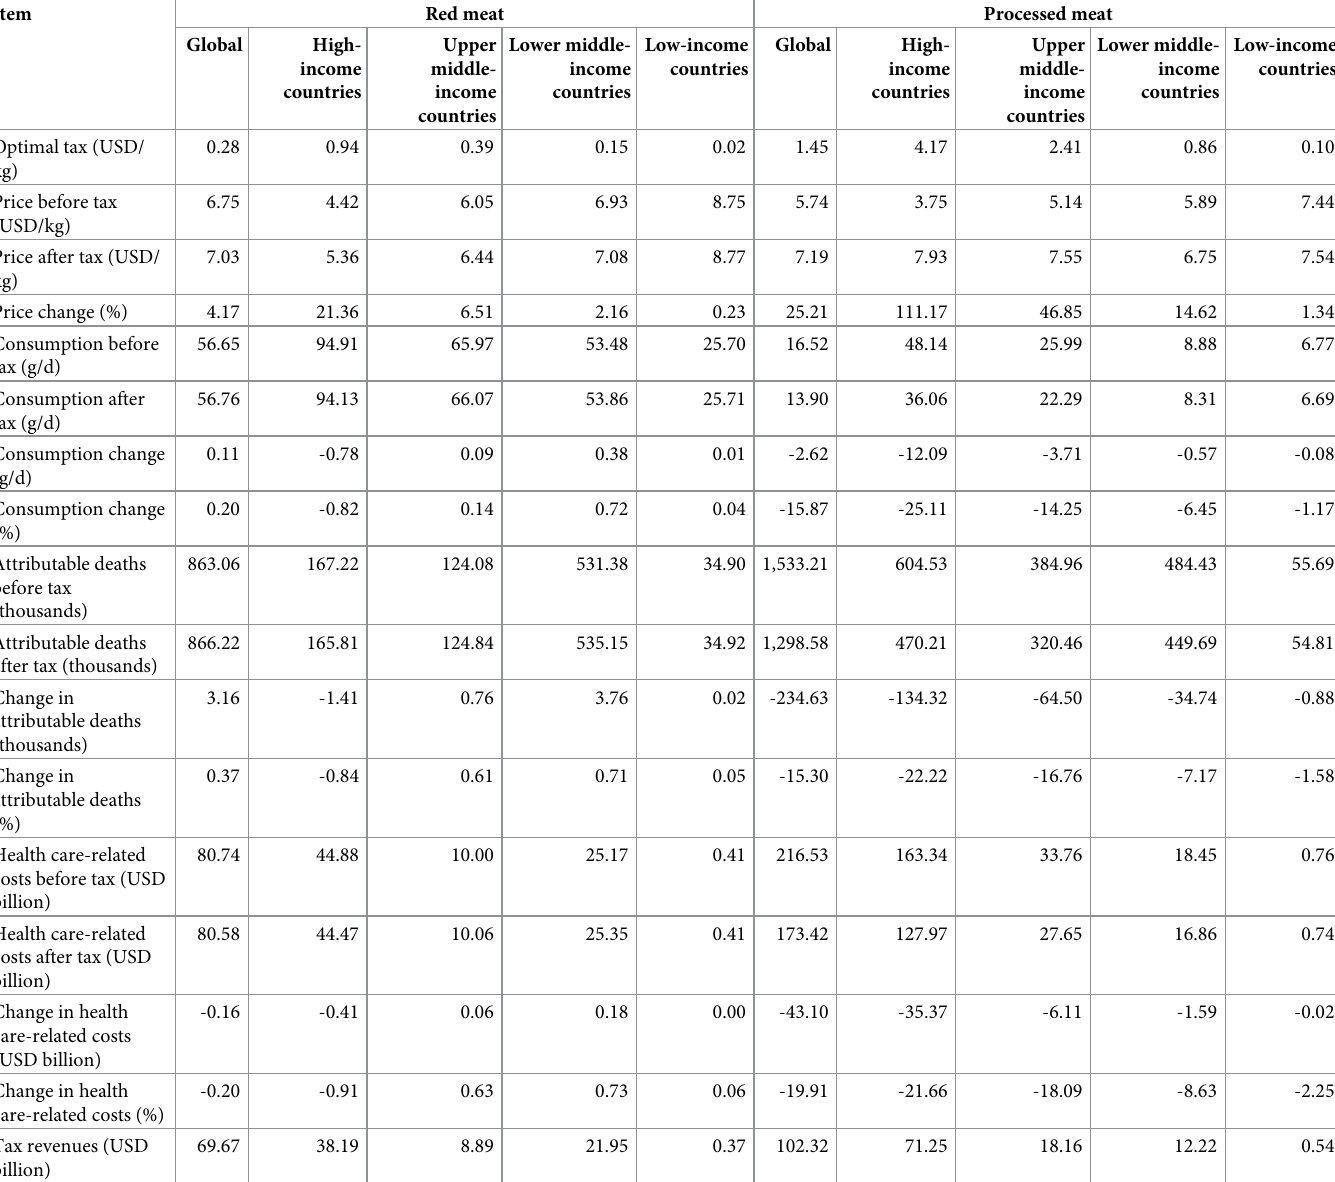
Table 1. Impacts of cost-compensating taxation of red and processed meat globally and by regions in different income categories.